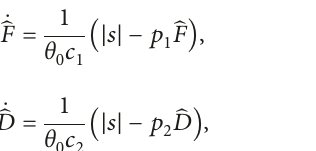
under the initial value ( i ) . 1